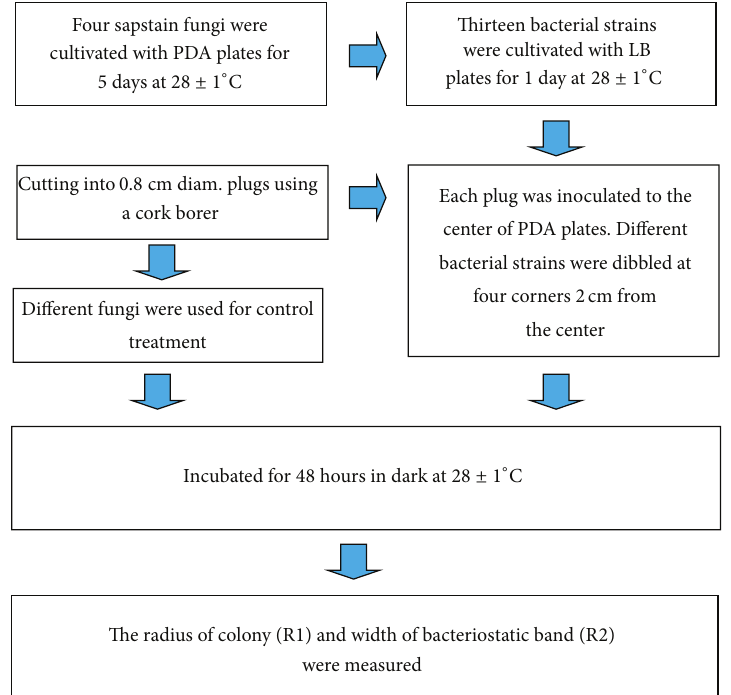
Figure 2: Method of screening for antifungal in vitro